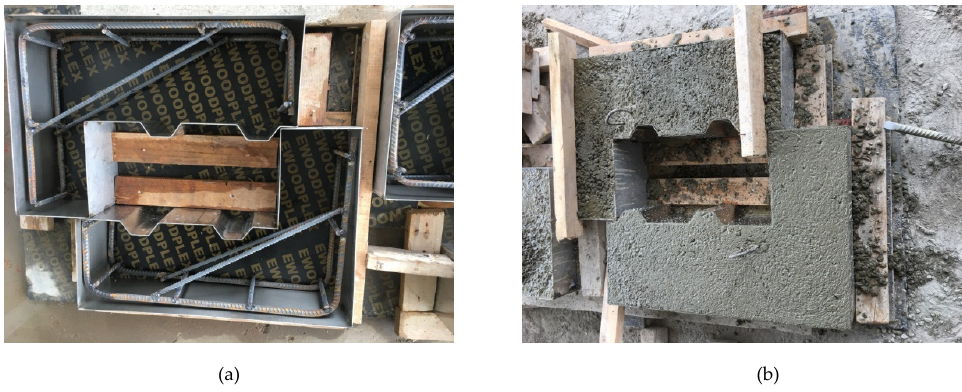
Figure 4. Construction process of push-off test specimens: ( a ) stainless steel machined molds; ( b ) pouring of concrete.